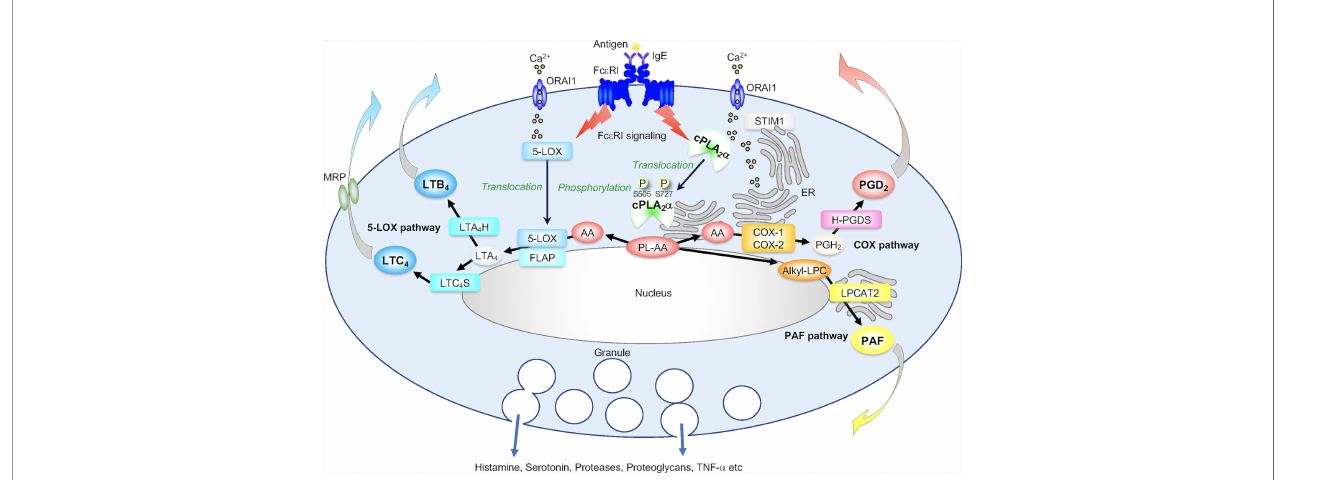
FIGURE 2 | The cPLA 2 a -eicosanoid axis. (A) The role of cPLA 2 a in generation of PGD 2 and LTs in IgE/antigen (Ag)-activated mast cells. Following Fc e RI-dependent signaling that is linked to STIM1/ORAI1-driven Ca 2+ in fl ux, cPLA 2 a translocates from the cytosol to the perinuclear, Golgi and ER membranes, where several downstream eicosanoid-biosynthetic enzymes are also located. The activity of cPLA 2 a is augmented by phosphorylation at Ser 505 by MAPKs, Ser 727 by MAPK- activated protein kinases (MAPKAPKs), and possibly other kinases. The AA released from AA-containing phospholipids (PL-AA) by cPLA 2 a is then metabolized into PGD 2 via the COX pathway involving COX-1 (or COX-2 if it is induced) and H-PGDS and into LTB 4 and LTC 4 via the 5-LOX pathway involving 5-LOX (which also translocates from the cytosol to the perinuclear membrane in response to Ca 2+ ), FLAP (a cofactor that presents AA to 5-LOX), LTA 4 H and LTC 4 S. Alternatively, cPLA 2 a -generated alkyl-LPC is acetylated by LPCAT2 to PAF. These reactions occur independently of degranulation and cytokine